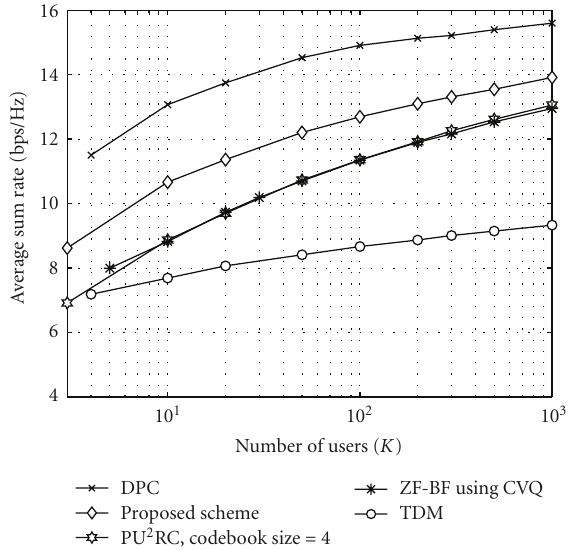
Figure 4: Sum rate of the proposed scheme compared to multiuser MIMO techniques using TBM (modified PU 2 RC), ZFBF with CVQ, and TDM with eigenmmode transmission for M = 3 Tx and N = 2 Rx antennas at 10 dB